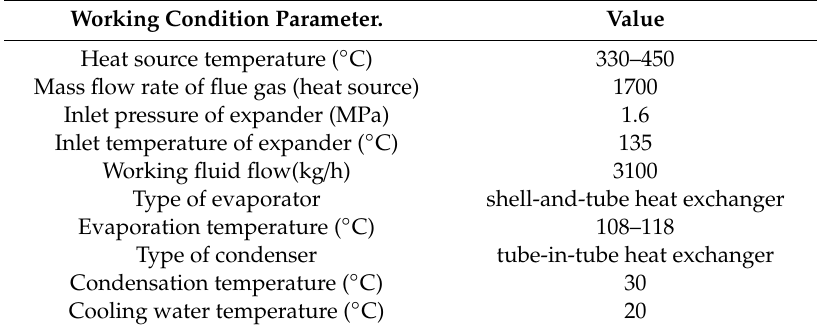
Table 1. Working condition parameters of the demonstration ORC system Working Condition